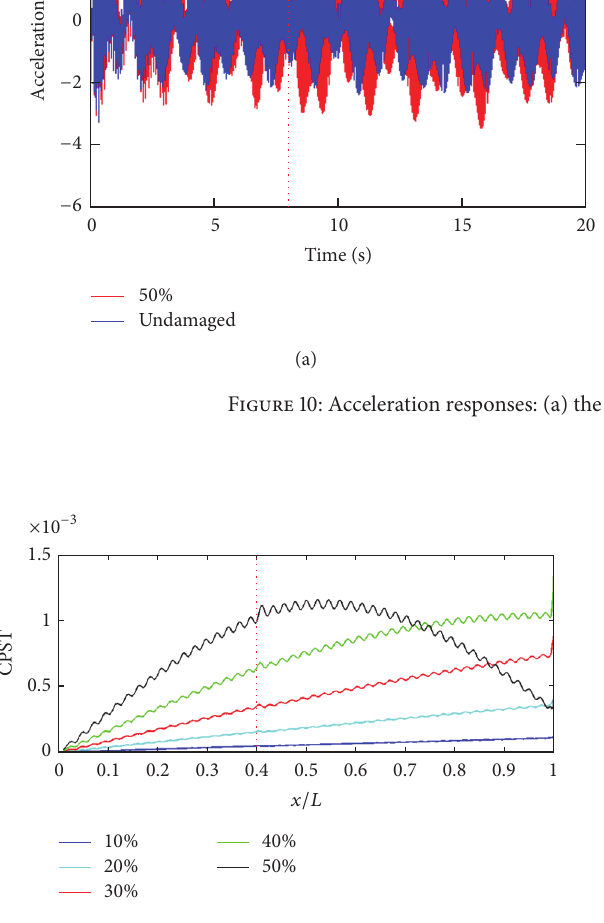
Figure 11: Unfiltered CPST of different damage levels using acceler- ation responses with the mass which is 50Kg.